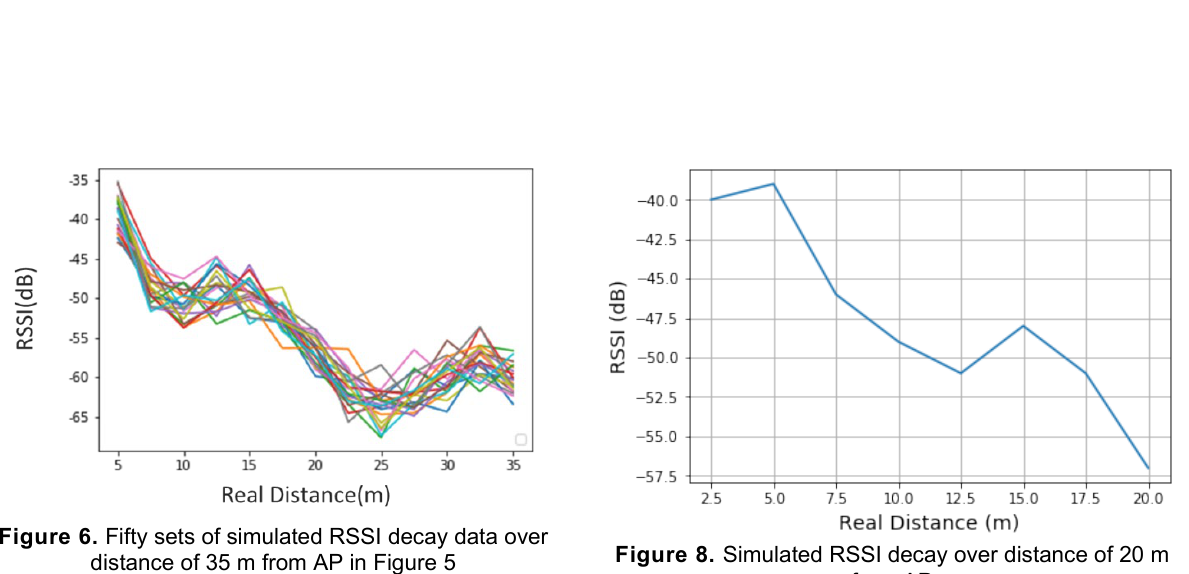
Figure 8. Simulated RSSI decay over distance of 20 m from AP